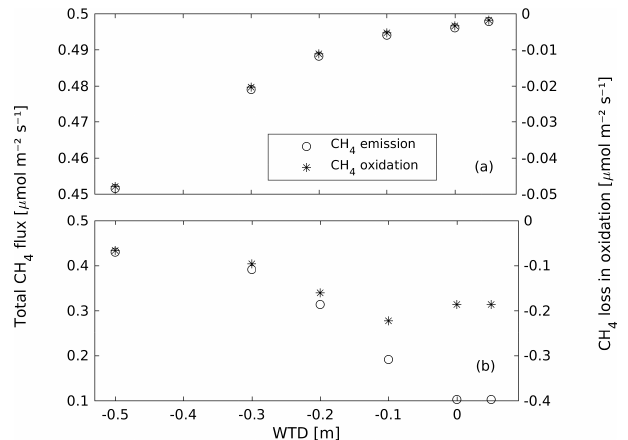
Figure 9. Dependence of the total CH 4 flux and CH 4 oxidation rate on WTD in (a) test W_L0_T10_R1 and (b) test W_L1_T10_R1. CH 4 oxidation is a negative flux since it is a loss of CH 4 .